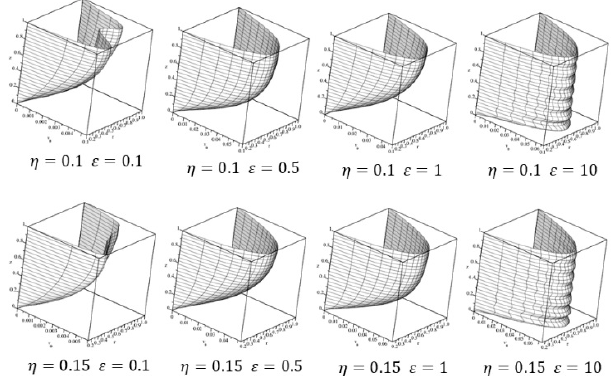
Figure 3. Annular channel cross-section and its main parameters: ℎ (channel depth), (cid:1870) (channel width), (cid:1844) (cid:2869) (inner cylinder radius), (cid:1844) (cid:2870) (external cylinder radius), (cid:1874) (cid:3087) (azimuthal velocity).